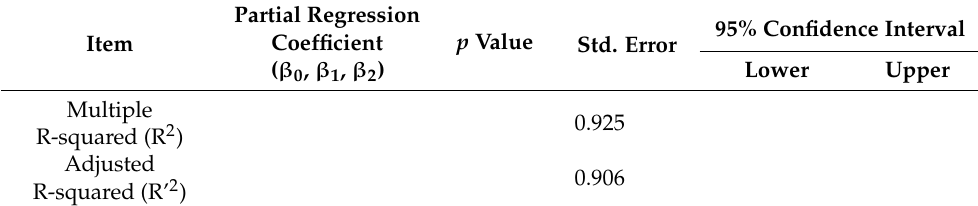
Table 6. Explanatory variable and response variable (CFL).